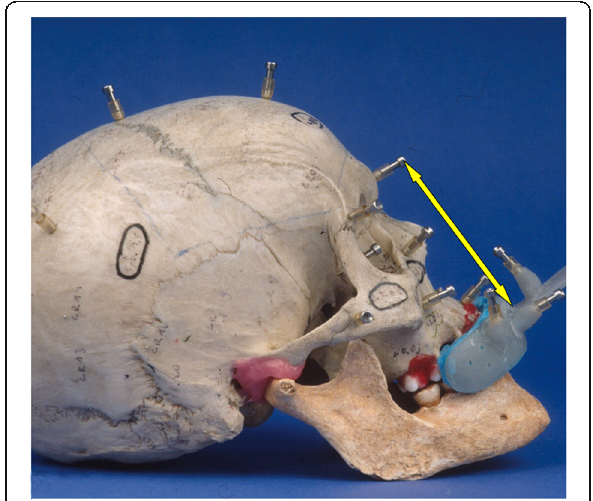
Fig. 1 Part of the skull's viscerocranium (detail) with a vestibular splint (VestS) and bone markers. The arrow shows the distance between the centre of the VestS and the bone marker at the